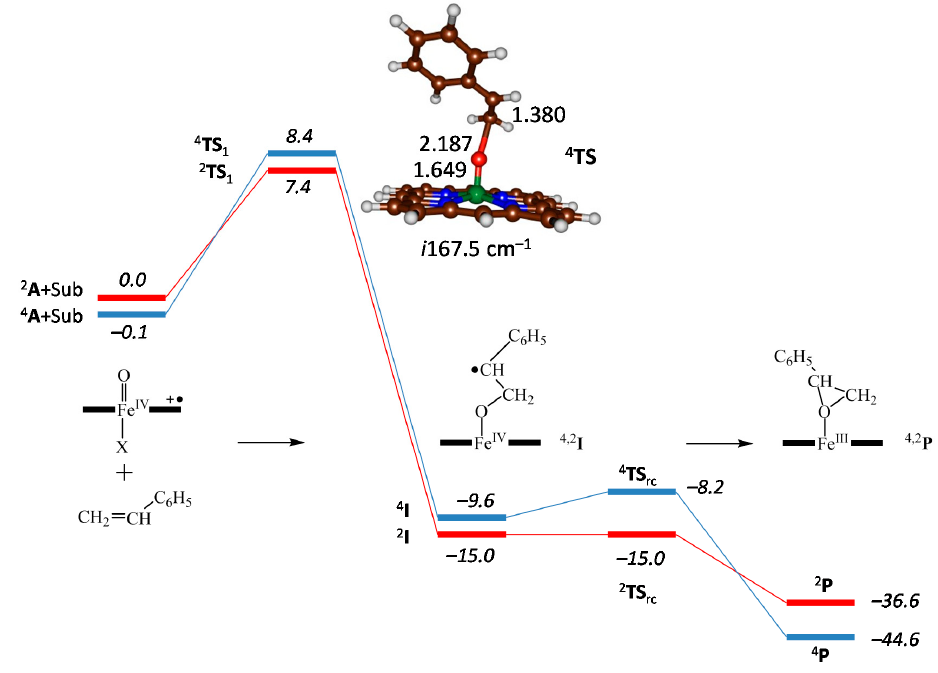
Figure 4. Potential energy landscape of styrene epoxidation by [Fe IV (O)(Por +• )Cl] as calculated with UB3LYP in Gaussian-09 with the quartet landscape in blue and the doublet landscape in red. Data taken from [61] and represents Δ E + ZPE values in kcal·mol − 1 relative to isolated reactants. Optimized geometry of the TS gives bond lengths in angstroms.